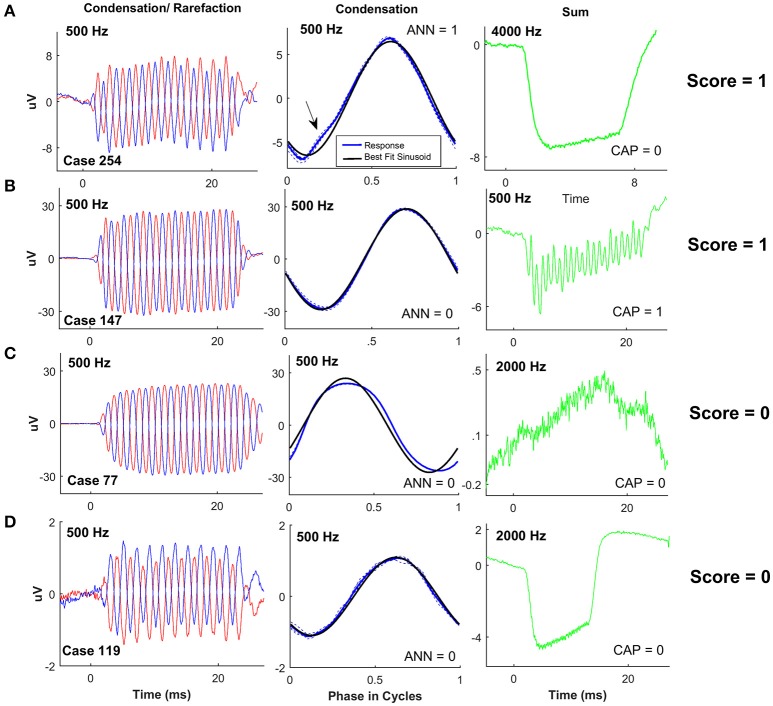
ECochG examples with minimal neural activity. (A) A case with a nerve score of 1, showing a small ANN (arrow) and no CAP, and a large negative SP. (B) Another case with a nerve score of 1, that had a phenotype with no ANN and a small CAP. (C) A case with no ANN or CAP, and no SP either. (D) Another case with no ANN or CAP, but a large negative SP.